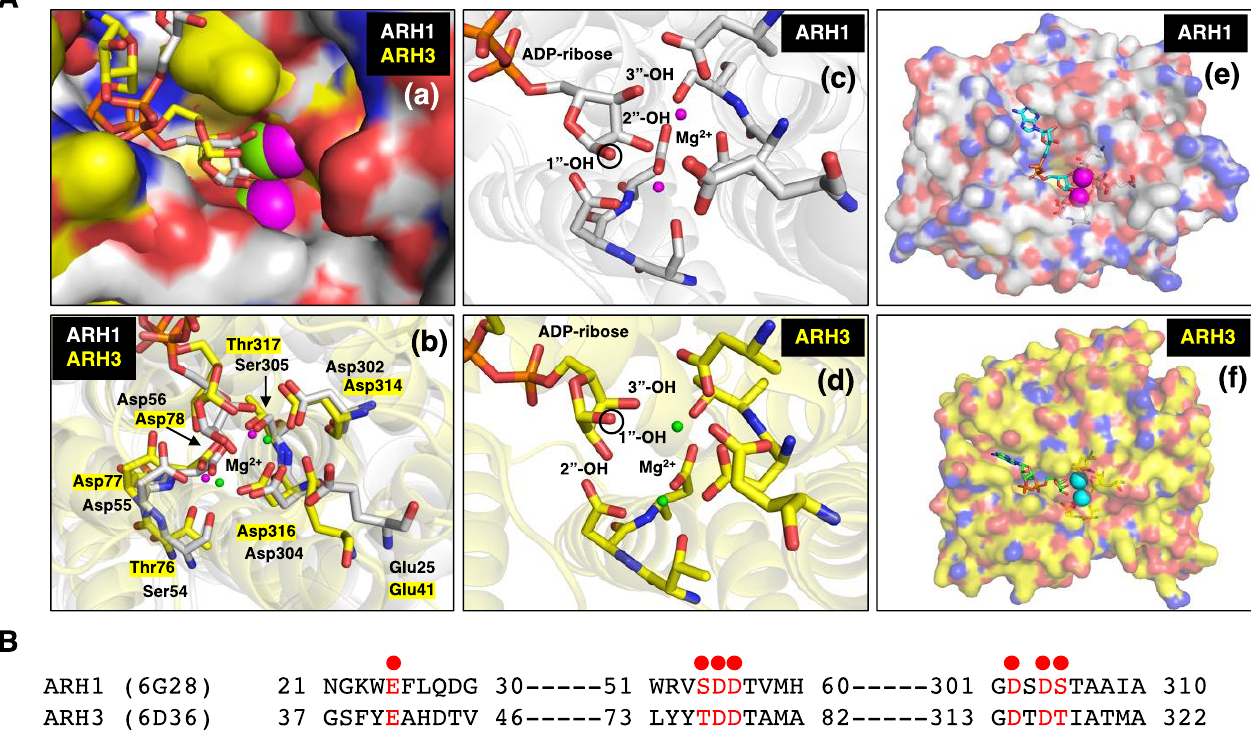
Figure 1. ( A ) ( a ) Close-up surface representation of human ARH1 (white, PDB ID: 6g28) [98] and ARH3 (yellow, PDB ID: 6d36) [99] crystal structures with electro-negative (red) and -positive atoms (blue). The binding pocket of ADP-ribose on surface of ARH1 and ARH3 is near the bound Mg 2+ ions (magenta-ARH1, green-ARH3) [23,76,98–100] . ( b ) Crystal structure of ARH1 and ARH3 with ADP-ribose and Mg 2+ ions (ARH1-magenta, ARH3-green). Glu25, Ser54, Asp55, Asp56, Asp302, Asp304, and Ser305 in ARH1, and Glu41, Thr76, Asp77, Asp78, Asp314, Asp316, and Thr317 in ARH3 (yellow highlight) hydrogen-bonding amino residues near Mg 2+ are critical for binding of ADP-ribose, and ARH1 and ARH3 hydrolase activities. ( c ) and ( d ) Close-up two Mg 2+ ions and ADP-ribose in binding pocket of ARH1 ( c ) and ARH3 ( d ). The black circle on ribose indicates the 1”- OH of ribose that is an attachment site of arginine or serine residue of modified protein, O -acetyl or nicotinamide of α-NAD + [28] . ( e ) and ( f ) Surface representation of human ARH1 (white, PDB ID: 6g28) and ARH3 (yellow, PDB ID: 6d36) crystal structures. ADP-ribose (cyan-ARH1, green-ARH3) and Mg 2+ ions (magenta-ARH1, cyan- ARH3) are bound in the pocket of ARH1 or ARH3. ( B ) Structure-guided alignment of selected ARH1 and ARH3 protein residues (red dot) bound with Mg 2+ ions. Crystal structures of ARH1 (PDB ID: 6g28) and ARH3 (PDB ID: 6d36) with bound ADP-ribose and magnesium were taken from the Protein Data Bank (https://www.rcsb.org, accessed on 13 October 2022). Figures and structure analysis were created with Pymol (http://pymolorg, accessed on 13 October 2022).